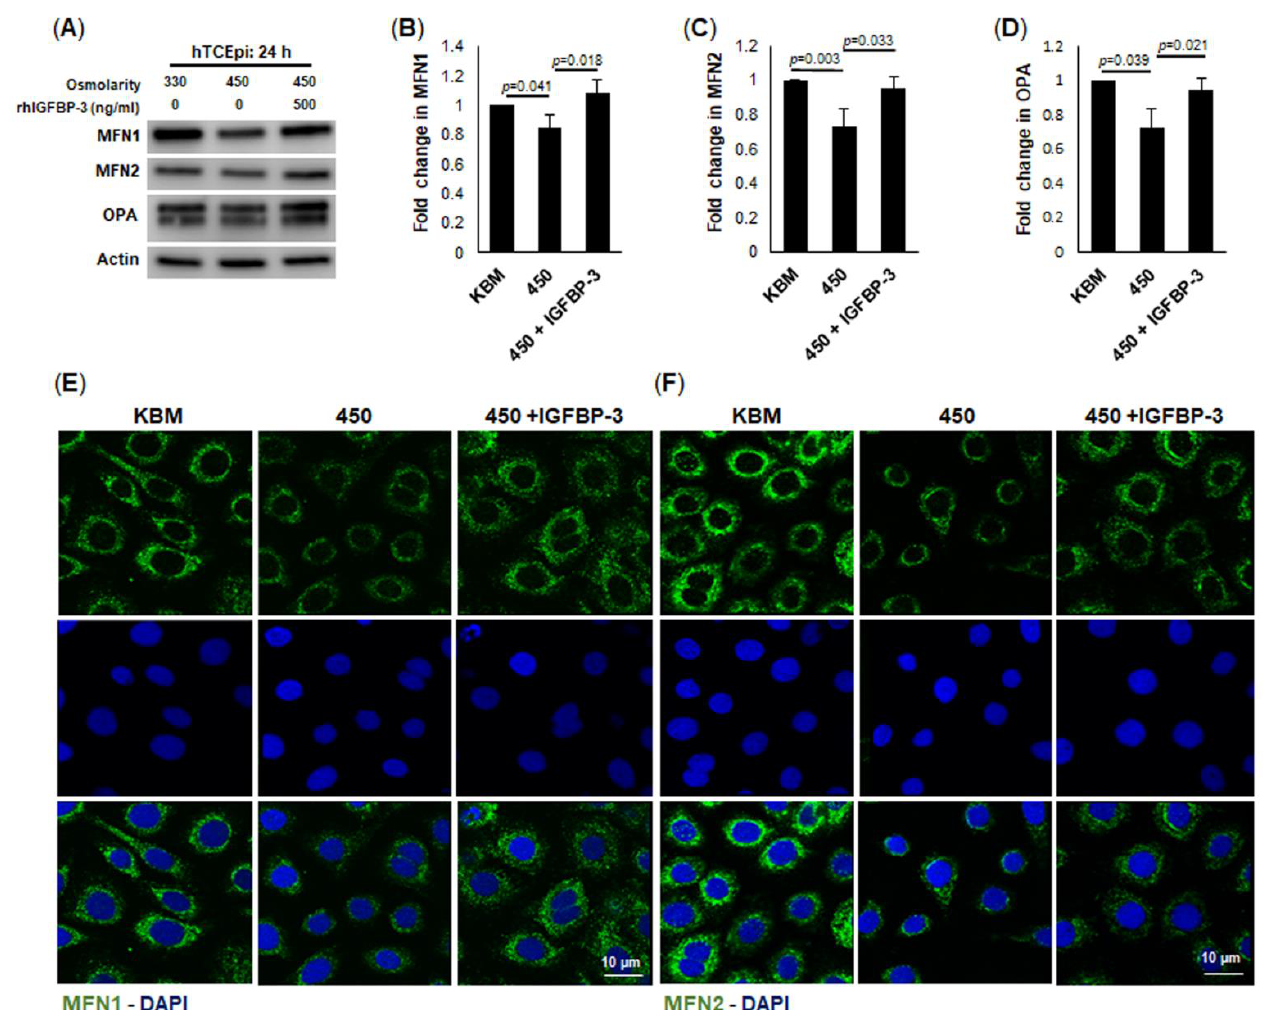
Figure 6. IGFBP-3 mediates fission defects in mitochondria under hyperosmolar stress. hTCEpi cells were treated with isotonic KBM or 450 mOsm KBM for 24 h. An additional set of cells in 450 mOsm KBM were co-treated with 500 ng/mL rhIGFBP-3. ( A ) Immunoblotting for MFN1, MFN2 and OPA. Expression of all 3 proteins decreased in 450 mOsm culture. These decreases were blunted by co- treatment with rhIGFBP-3. β -actin was used as a loading control. ( B – D ) Quantification of MFN1 ( B ), MFN2 ( C ), and OPA1 ( D ). ( E , F ) Immunofluorescent staining for MFN1 (green, E ), and MFN2